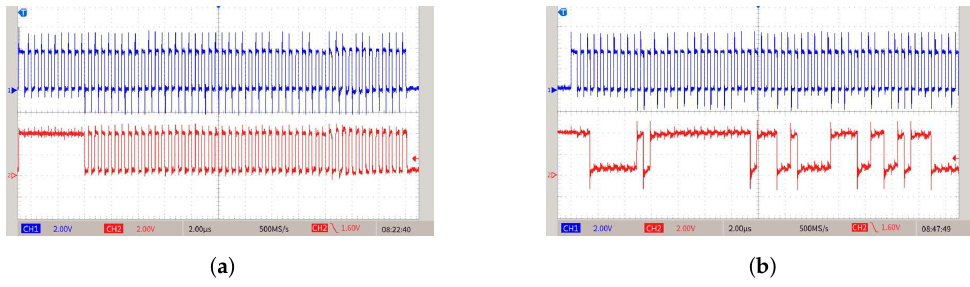
Figure 19. Measured signals for 2 MHz MA frequency. ( a ) MA (blue) and SPICLK (red). ( b ) MA (blue) and SLO data signal (red).